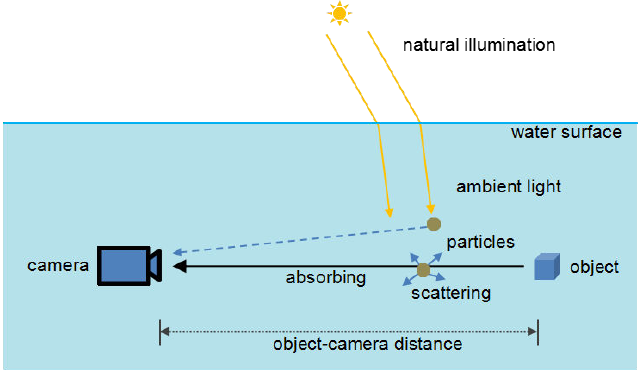
Figure 2. The schematic diagram of underwater optical